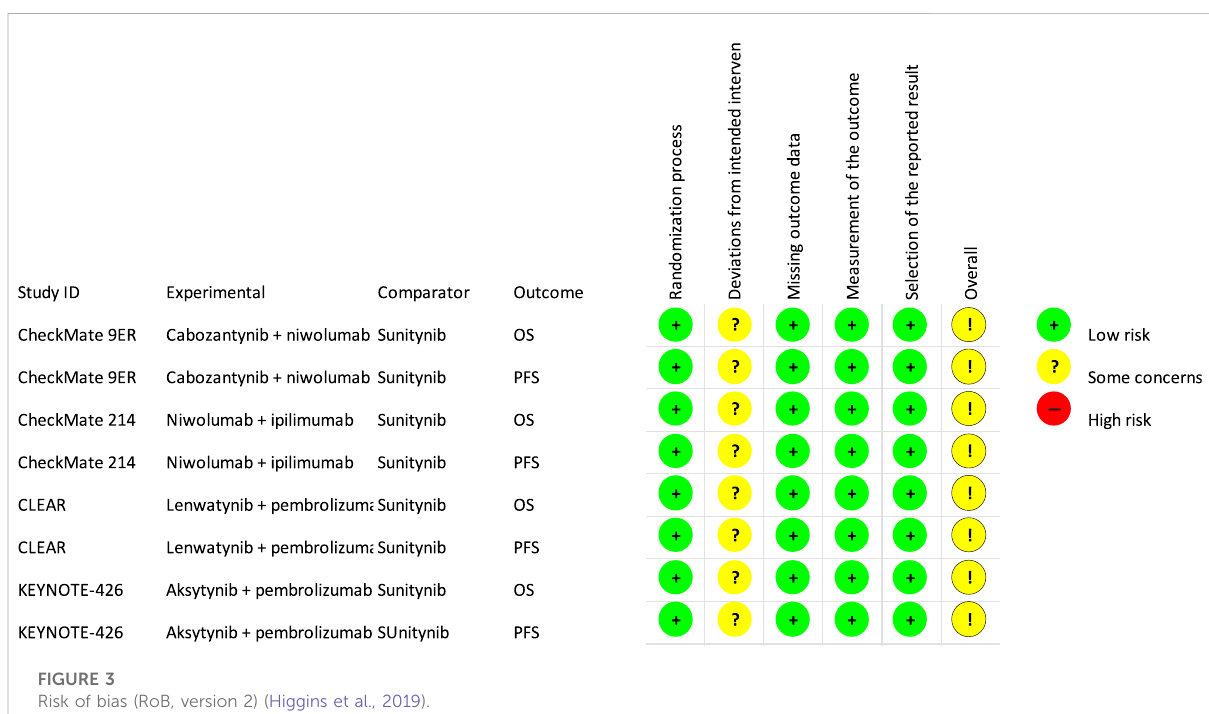
FIGURE 3 Risk of bias (RoB, version 2) (Higgins et al., 2019).